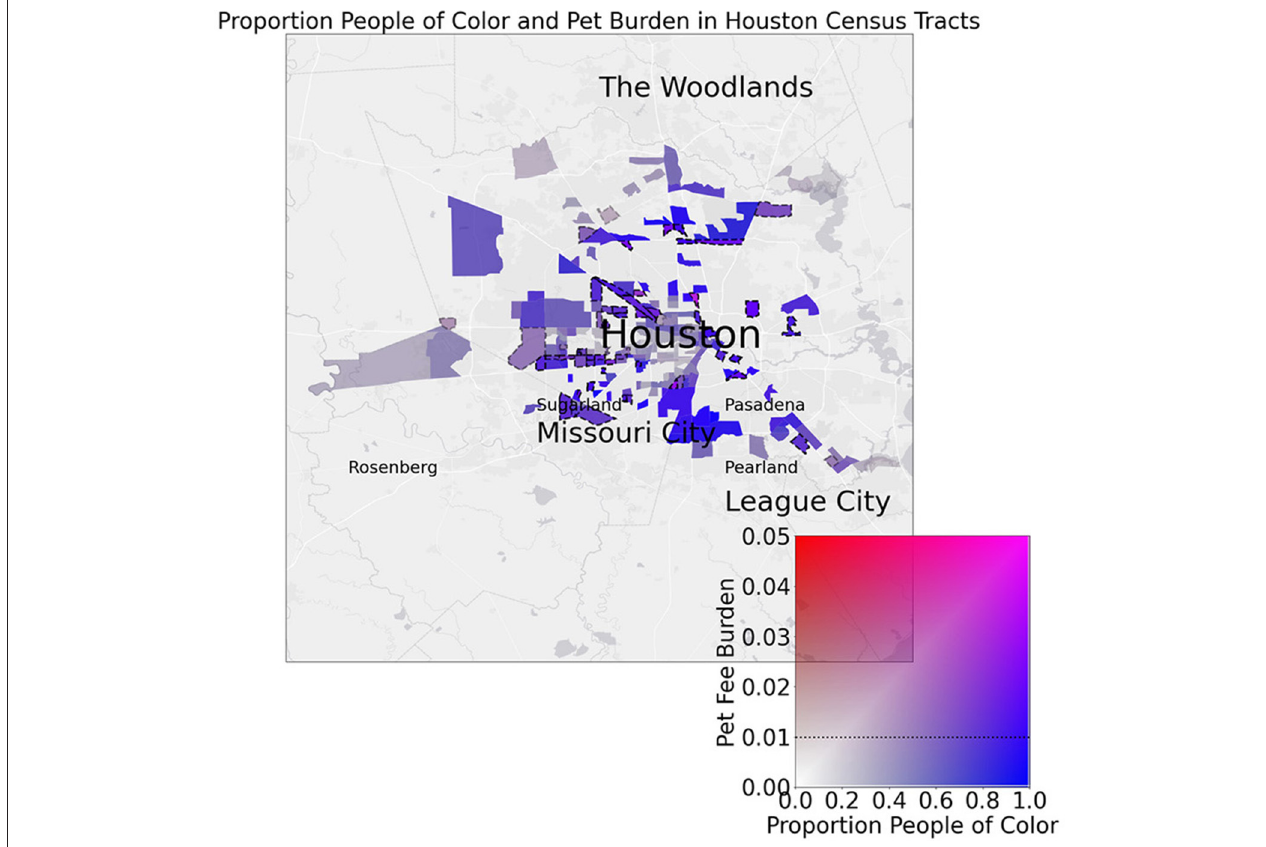
FIGURE 7 | Map displays spatial relationships between census tracts’ proportion of people of color (POC) and pet fee burden in Houston. Dotted lines around tracts indicate a 1% (0.01) or greater pet fee burden. Note that highly blue tracts indicate low burden POC areas while purple regions indicate high burden POC areas. Red indicates high burden, low POC areas while transparent regions have low POC and low